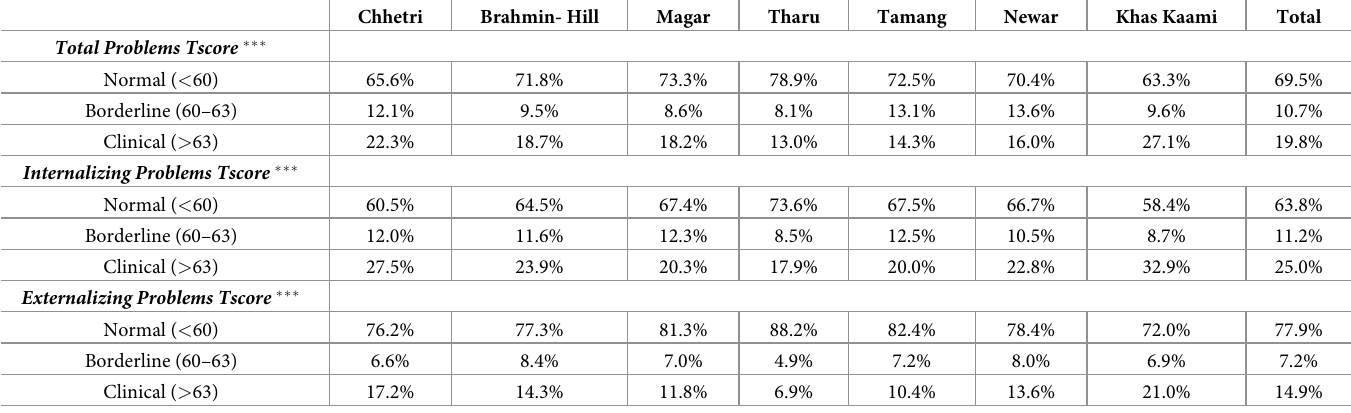
Table 3. Prevalence of EBP for the seven largest castes and ethnic